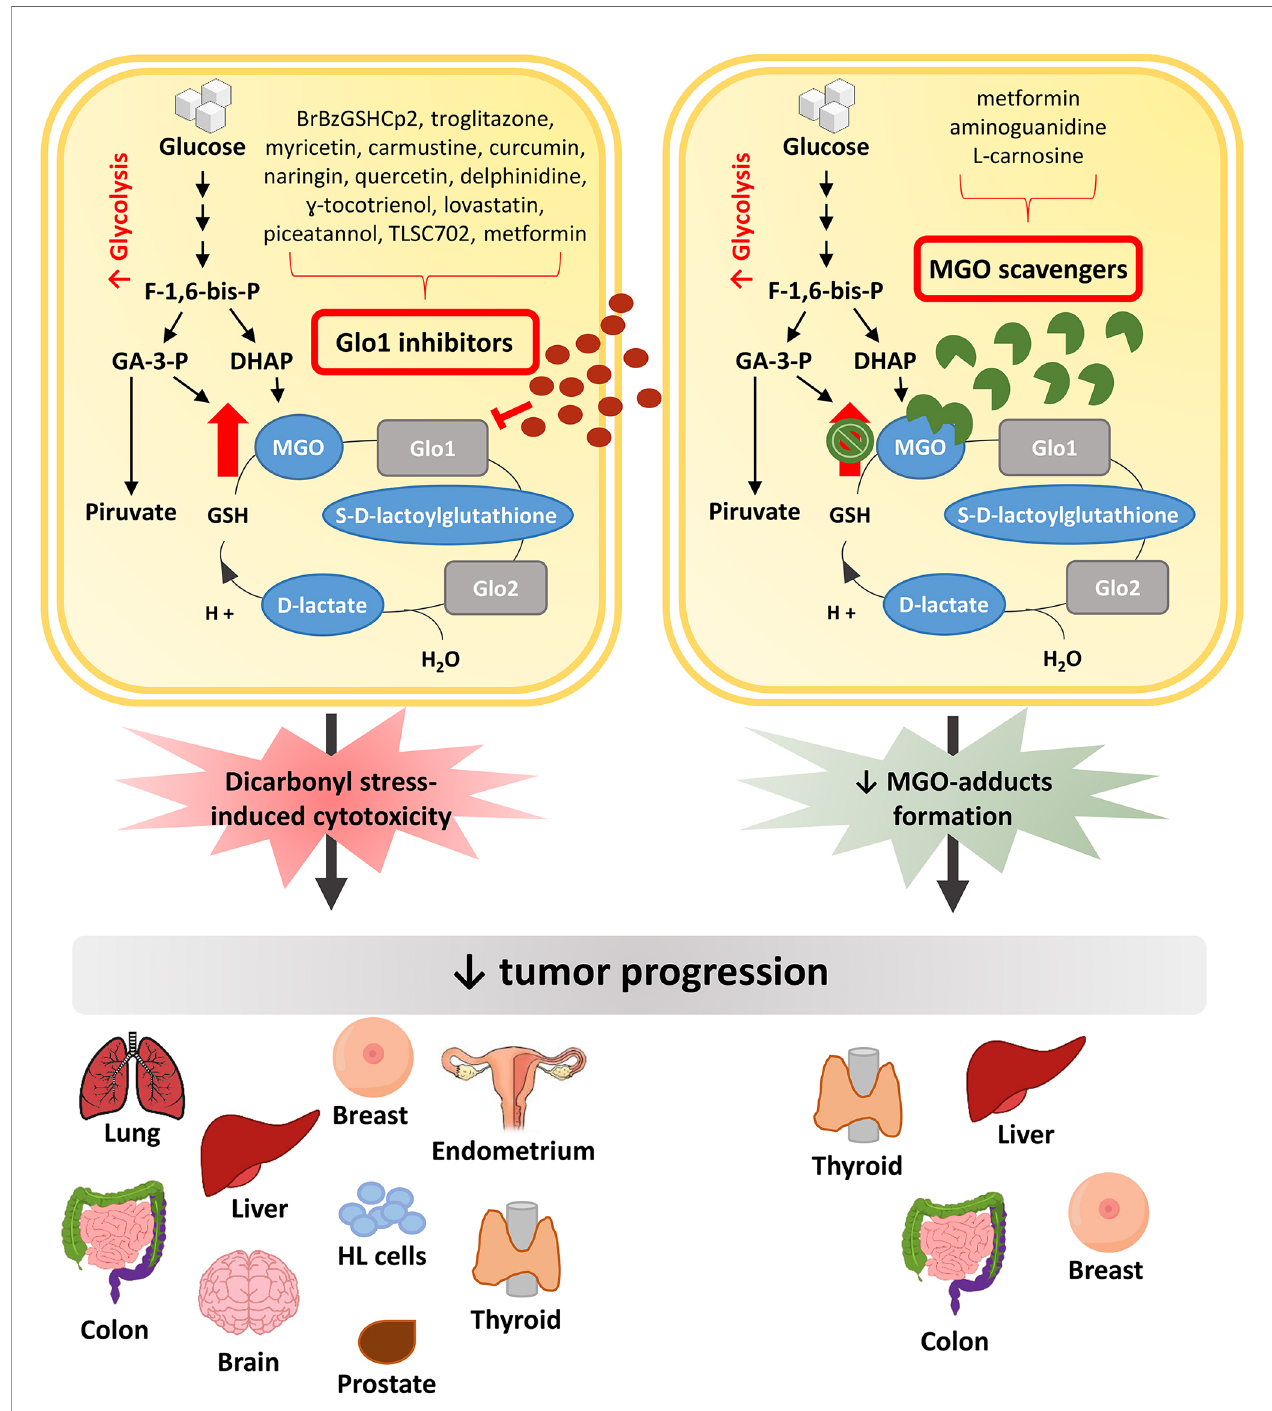
FIGURE 2 | Anti-tumor pharmacological strategies. In cancer cells, the increased glycolytic fl ux causes a higher MGO production which can sustain tumor growth. Glo1 inhibitors block tumor progression by further increasing MGO intracellular levels and leading to dicarbonyl stress-induced cytotoxicity. Differently, MGO scavengers, by trapping MGO and reducing MGO-induced adducts formation, are able to block tumor progression preventing the cytotoxicity related to high MGO levels. MGO, methylglyoxal; Glo1, Glyoxalase 1; Glo2, Glyoxalase 2; F-1,6-bis-p, fructose-1,6-bis-phosphate; GA-3-P, glyceraldehyde 3-phosphate; DHAP, dihydroxyacetone phosphate; HL cells, Human Leukemia